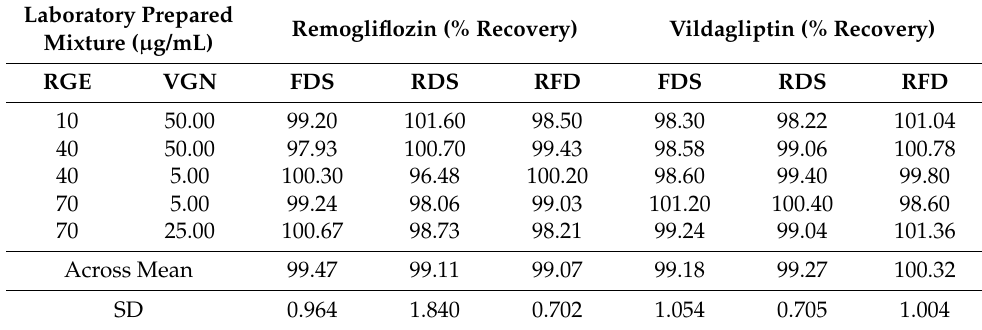
Table 2. Assay results of the laboratory mixed solutions of VGN and